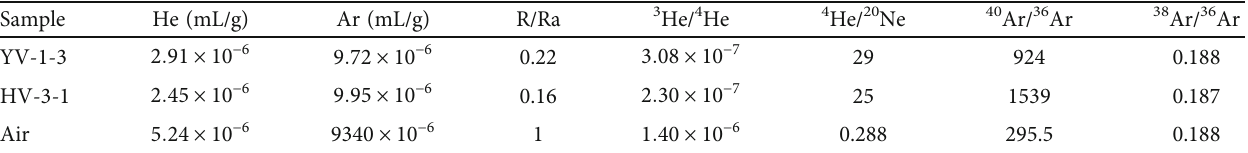
Table 4: Contents and ratios of helium and argon isotopes within the air and Longtan tight sand gas in west Guizhou.